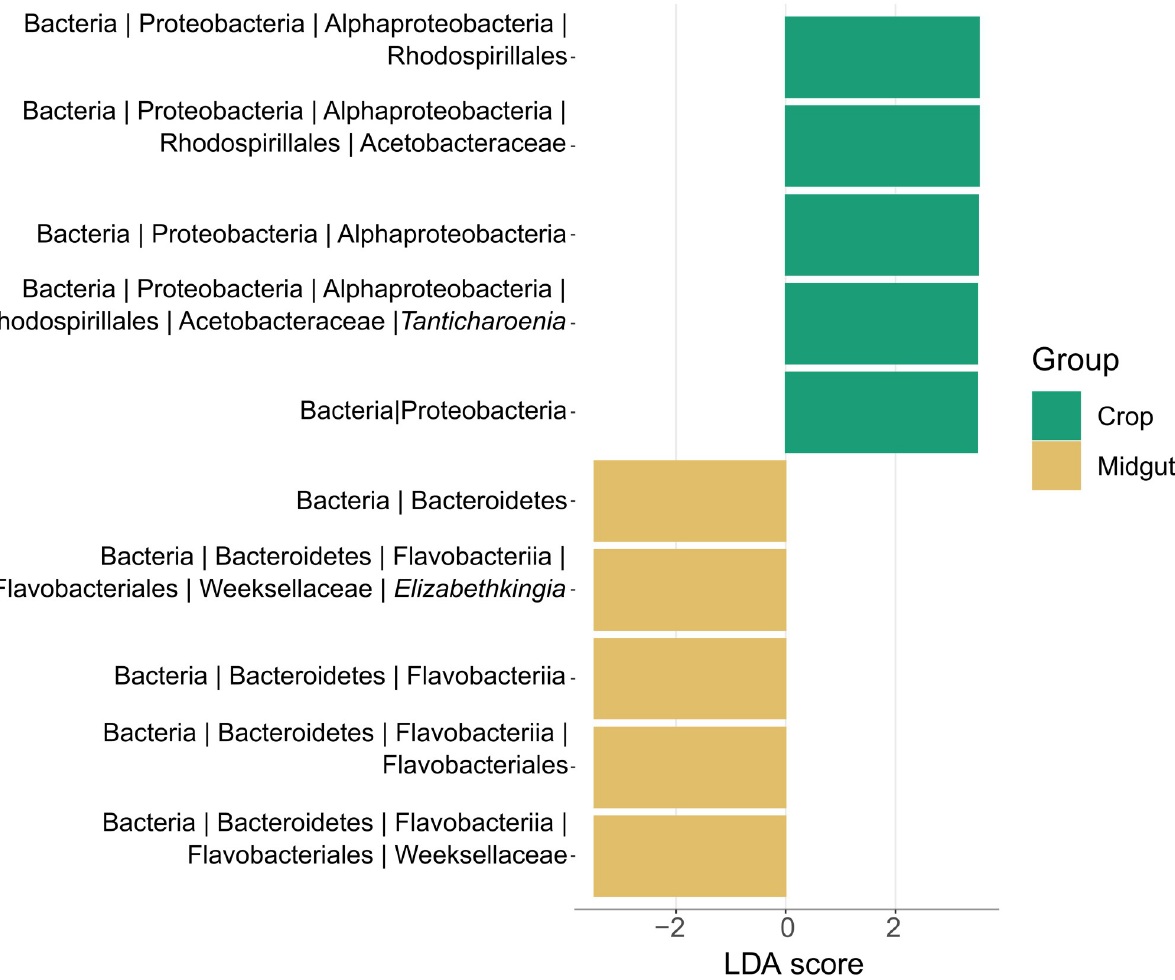
Fig 7. Tissue specific biomarkers determined by LDA scores using LEfSe method. At an LDA cutoff point of 3 (p < 0.01), two bacterial clades representing three ASVs were identified as significantly differentially abundant between tissues.